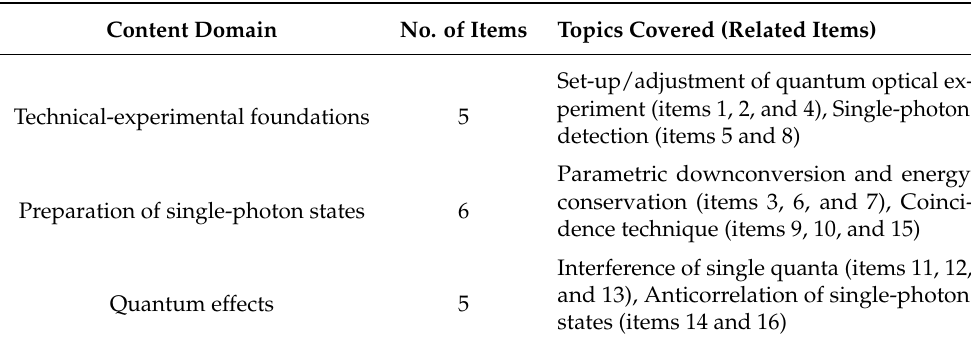
Table 1. Overview of the content domains covered in the Quantum Optics Concept Inventory, and the topics addressed with the related items. For a didactically prepared overview of the subject-specific topics represented in the test, e.g., the anticorrelation of single-photon states (see [18,51]). The list of items is given in Appendix